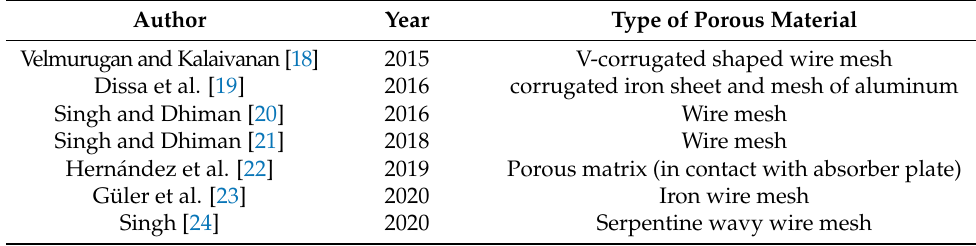
Table 2. Summary of different types of porous materials in numerical